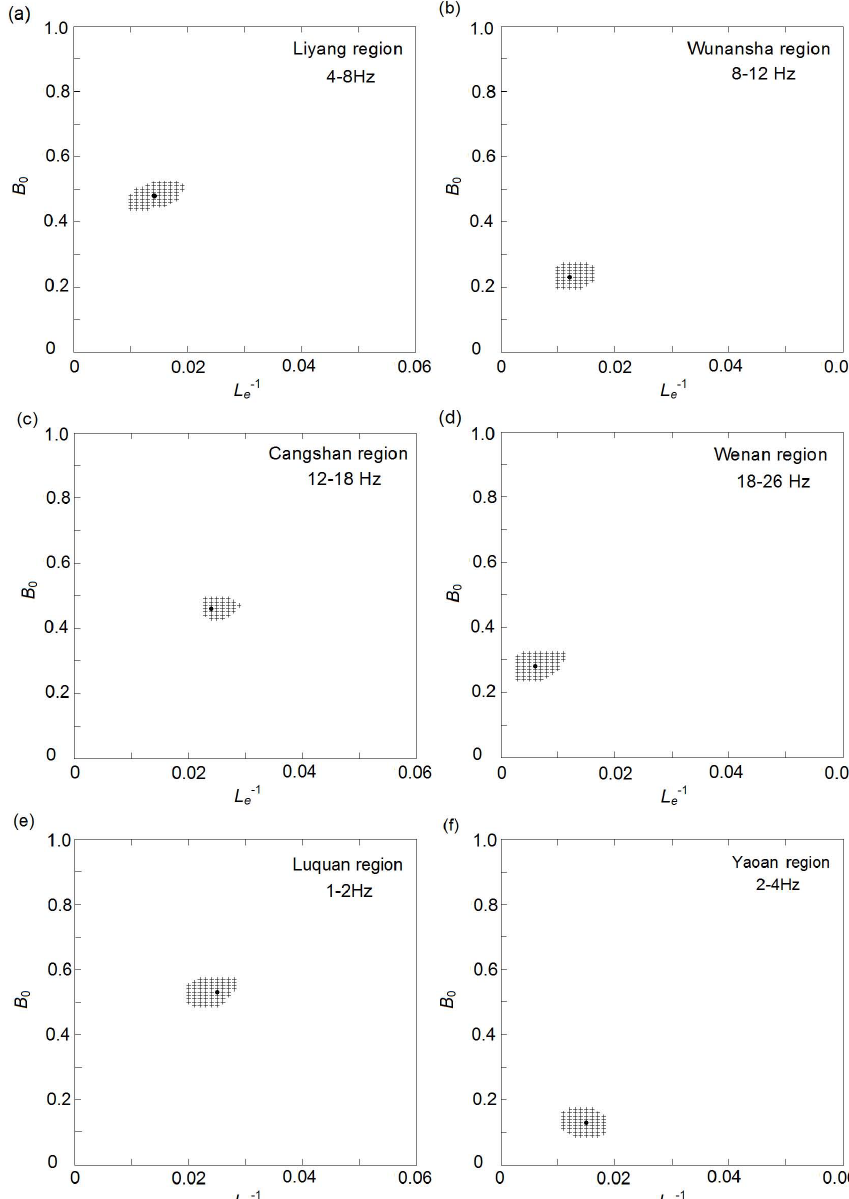
Fig. 5. Some examples of residual maps for partial frequency bands in the six regions. The 90% confidence regions are represented by cross symbols, and the pairs B 0 and L − 1 e which correspond to minimum residual are represented by